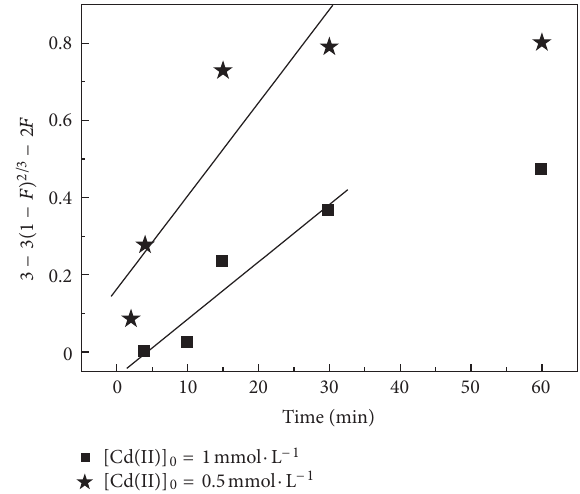
F 8: Plot of the moving boundary particle diffusion model for the Cd(II) adsorption on graed resin, m = 0.030g, V = 5mL, and initial pH =